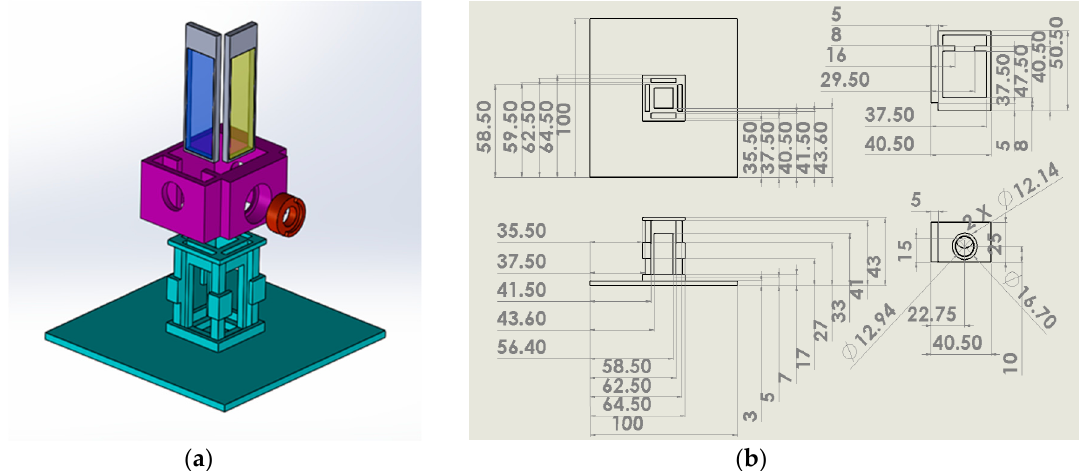
Figure 3. Computer aided design (CAD) of the main module: ( a ) top 3D view including filter holder (gray region), LED & lens holder (purple region), cuvette holder (green region), and lens and PD holder (red region); ( b ) isometric view of cuvette holder, lens, and PD holder parts. The stained cells were filled up to 3 mL in PBS with specific cell concentrations in a glass cuvette and irradiated in the dark for 5 min at ambient temperature to measure the FSC and SSC. For among Tahitian Blue (#369, 470 nm) or Night Blue (#74, 480 nm) of a commercial filter booklet. The